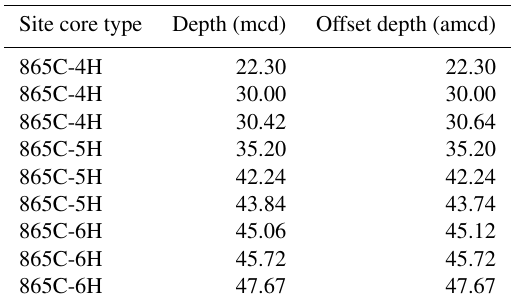
Table 3. Mapping pairs for adjusting mcd to amcd for ODP Hole 865B.